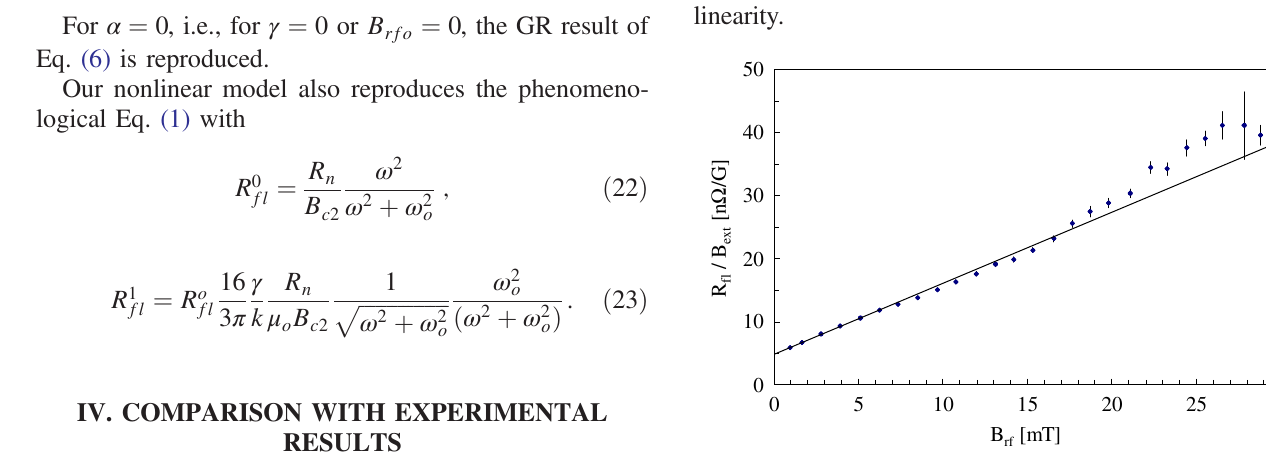
FIG. 2. The dependence on B cavities. The line is a fit to the data of the form R 0 (Reprinted from Ref. [6] with STM